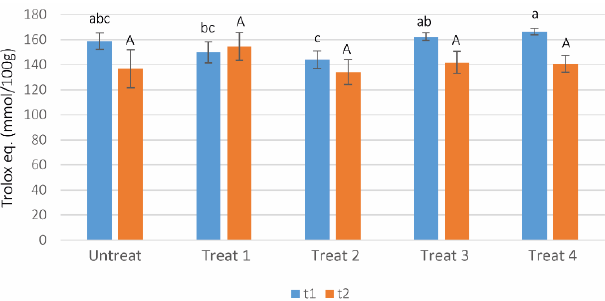
Figure 7. Total antioxidant capacity of hop leaf samples in each treatment at the two times (t1 and t2). Means followed by different capital or lowercase letters significantly differ ( p < 0.05) among the samples at the same time. Lowercase letters are used for t1 results, and capital letters are used for t2 results.